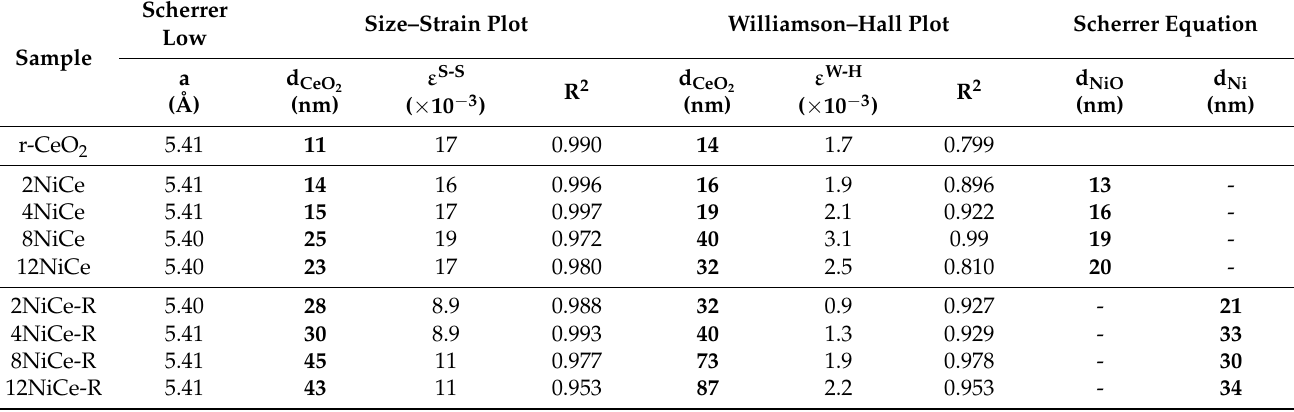
Table 4. Geometrical parameters and particle dimensions of CeO 2 , NiO, and Ni nanoparticles on samples calcined (NiCe) or reduced at 800 ◦ C (NiCe-R), calculated from X-ray diffraction (XRD) peaks using different